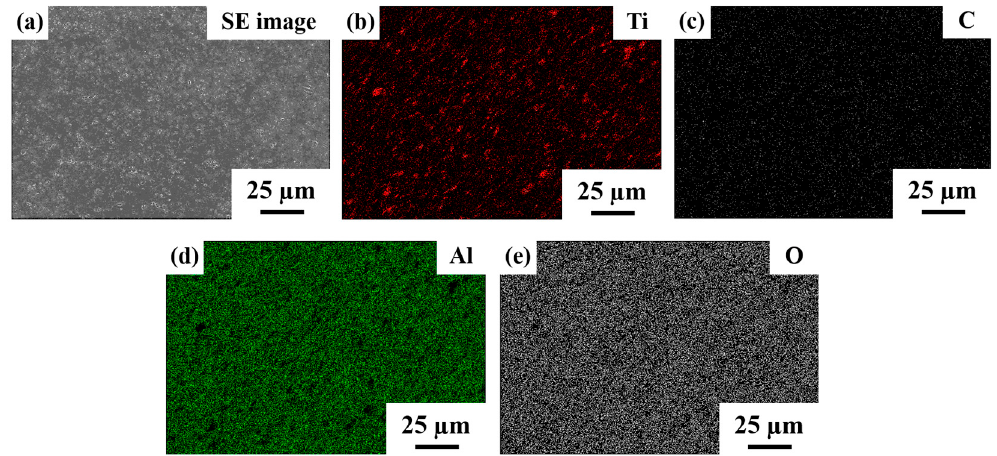
Figure 4. EDX mapping pf the sintered Al 2 O 3 -TiC composite without binder ( a ) secondary electron image, ( b ) Ti, ( c ) C, ( d ) Al, and ( e ) O phases.